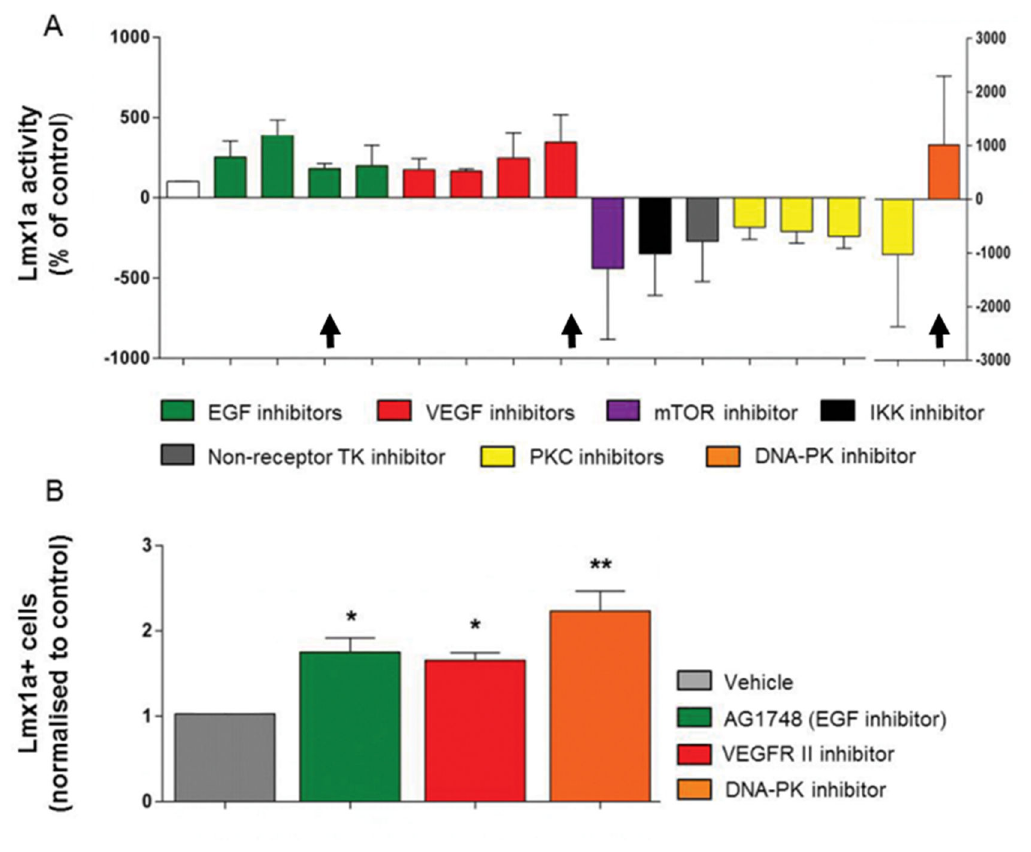
Figure 1. Small molecule inhibitor screens reveal multiple inhibitor classes effect Lmx1a reporter gene expression. 143 kinase inhibitors were screened yielding 16 small molecule agents (SMAs) for further analysis. Panel A shows Luciferase activity on day 8 of differentiation after incubation of Lmx1a - luc mESCs with SMAs from day 4 to day 8. Panel B shows that incubation with inhibitors that promote Lmx1a activity also increases the generation of Lmx1a+ cells. Color coded bars in A represent different SMAs with known similar kinase inhibitory activity, where black arrows indicate SMAs selected for analysis in panel B See Figures S1 and S2 for compound libraries used. Data expressed as mean ± SEM of at least four independent experiments. **p<0.01 and *p<0.05 one-way ANOVA with Bonferroni’s post-hoc test,